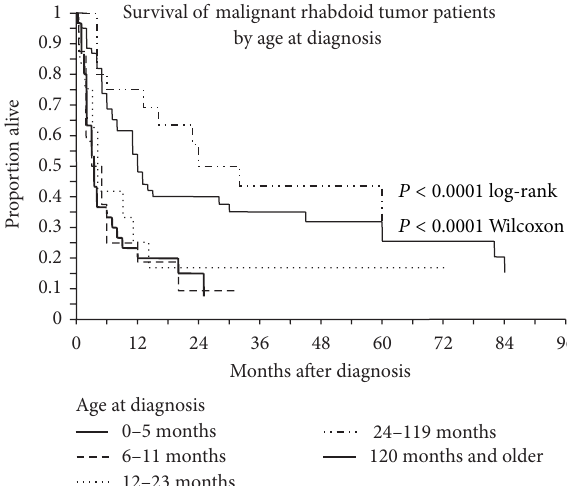
Figure 2: Analysis of age at diagnosis and survival. Kaplan-Meier survival curves of patients diagnosed with extrarenal extra-CNS malignant rhabdoid tumor. Age classes under 2 years old were indistinguishable. Age class 2–10 years had the best prognosis and were significantly different than those age classes under 2, but were not different from the > 10-year-old age group. The > 10 age group was significantly different from the < 2-year-old